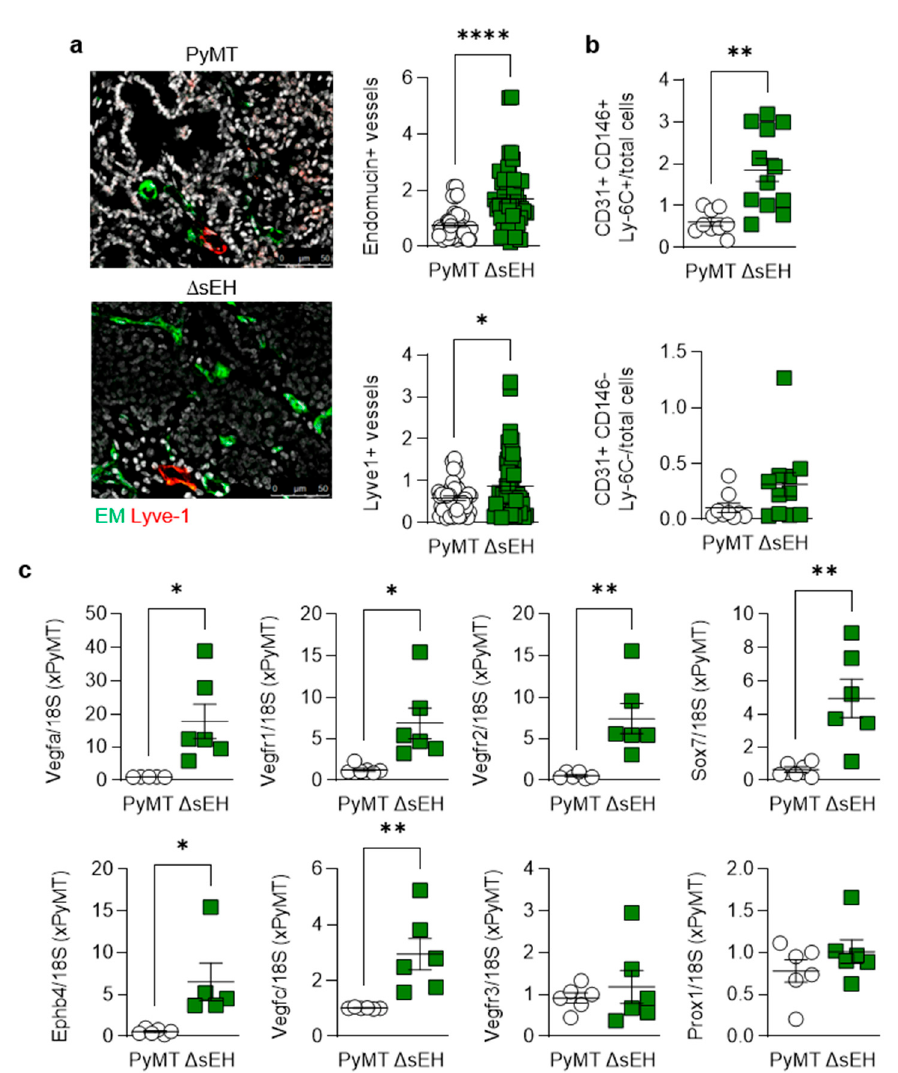
Figure 3. Angiogenesis and lymphangiogenesis in primary tumors. Primary tumors were removed from 20-week-old PyMT and PyMT Δ sEH ( Δ sEH) mice. ( a ) Vascular endothelial cells; endomucin+ (EM, green) and lymph endothelial cells (Lyve-1+, red); bar = 50 µm. n = 8–12 animals per group with 5 sequential slides evaluated per tumor. ( b ) FACS analysis of primary tumor digests for endothelial cells (CD31+, CD146+, Ly-6C+) and lymph endothelial cells (CD31+, CD146-, Ly-6C-); n = 9–13 animals per group. ( c ) Expression of angiogenesis markers (VEGFA, VEGFR1, VEGFR2, SOX7, EphB4) and lymph angiogenesis markers (VEGFC, VEGFR3, and Prox1) in primary tumors; n = 6 animals per group. * p < 0.05, ** p < 0.01, **** p < 0.0001 (Student’s t test). Primary tumors also displayed differences in inflammatory cell infiltration as more F4/80-expressing cells (macrophages) were detected in tumors from PyMT Δ sEH mice (Fig- ure 4a).